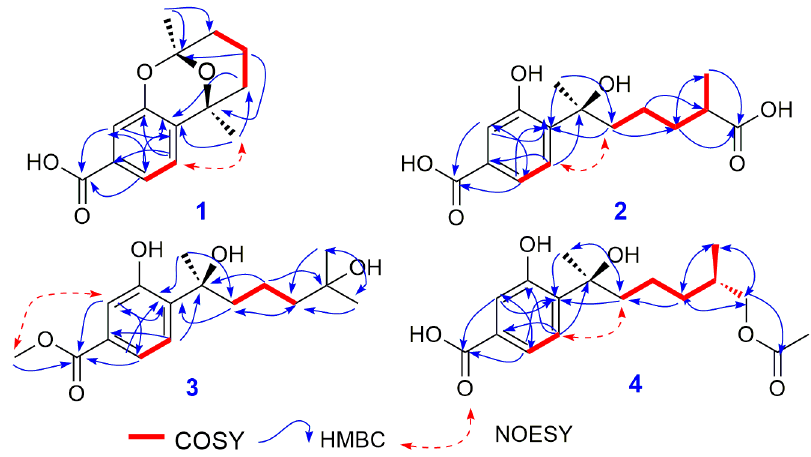
Figure 2. The COSY and key HMBC NMR correlations of compounds 1 – 4 .